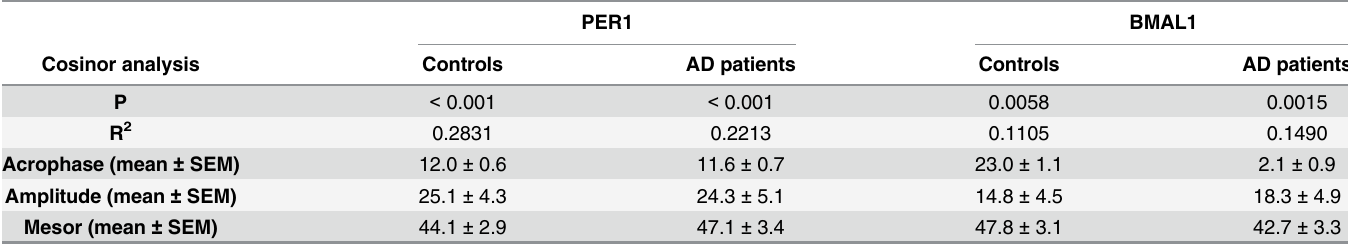
Table 2. Results of cosinor analysis of the clock gene expression